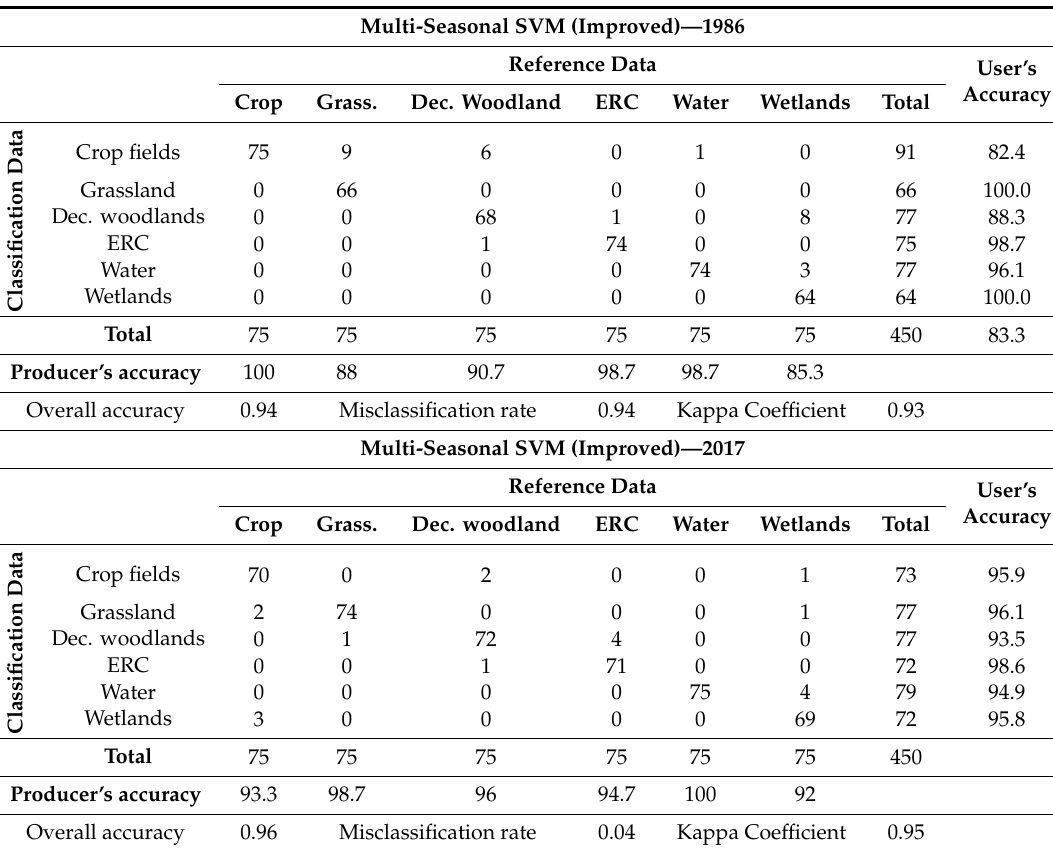
Table 2. Error matrix for multi-seasonal SVM (improved)